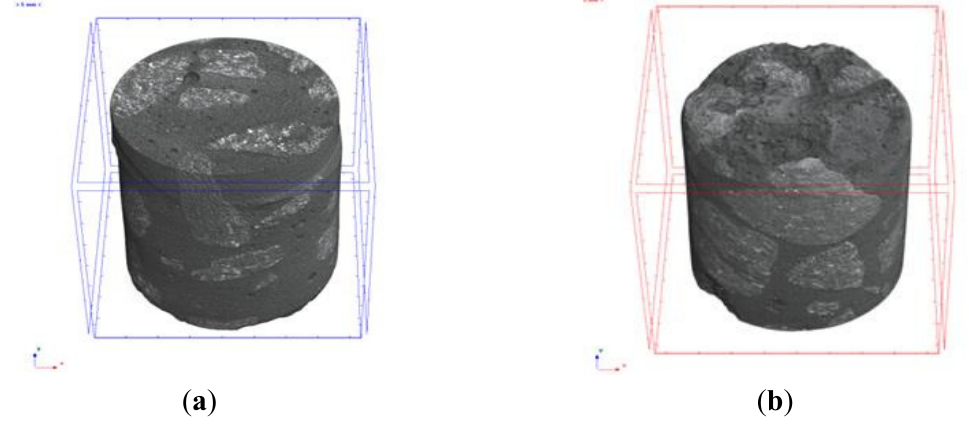
Figure 6. ( a ) Microtomography image of SCC samples and ( b ) of CC